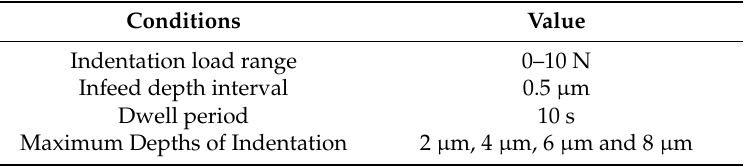
Table 1. Specifications of sequential loading-unloading indentation tests.